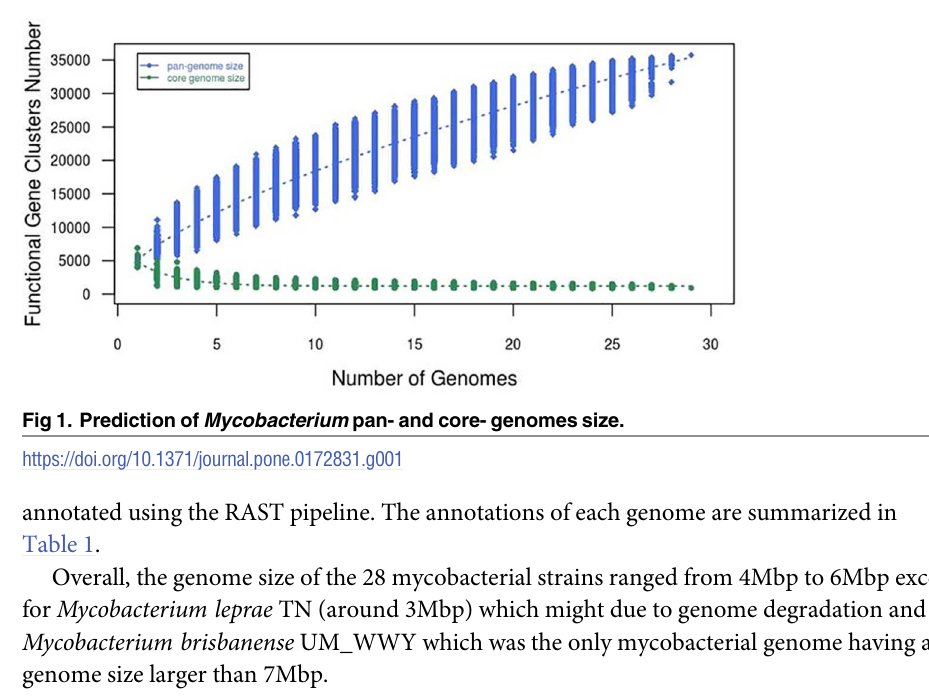
Table 1. Overall, the genome size of the 28 mycobacterial strains ranged from 4Mbp to 6Mbp except for Mycobacterium leprae TN (around 3Mbp) which might due to genome degradation and Mycobacterium brisbanense UM_WWY which was the only mycobacterial genome having a genome size larger than 7Mbp.